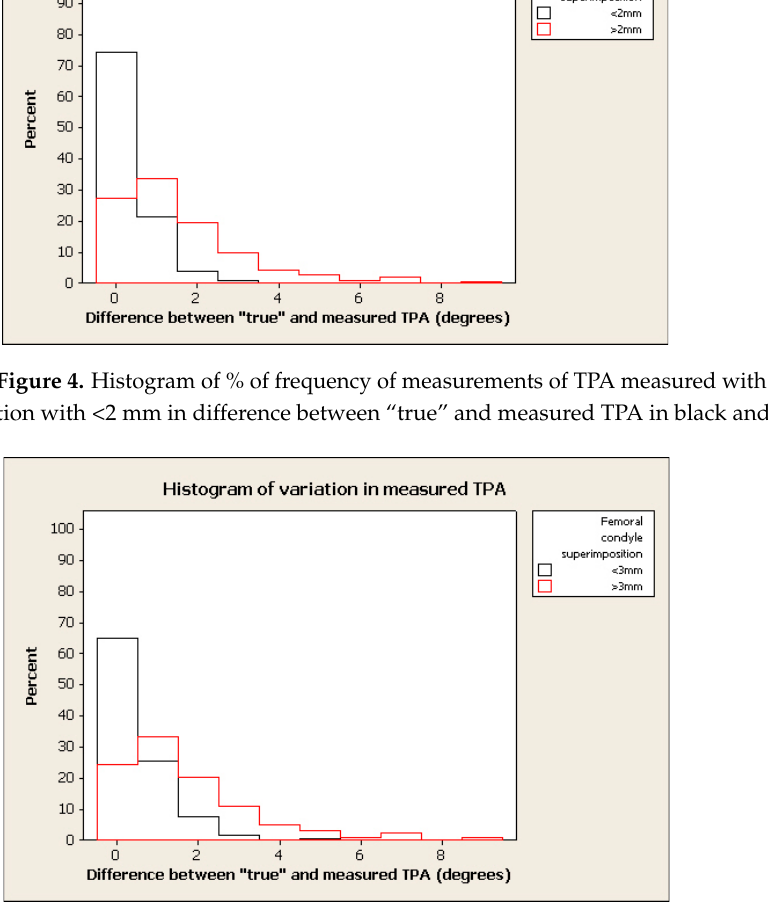
Figure 5. Histogram of % of frequency of measurements of TPA measured with femoral superimposition with <3 mm in difference between “true” and measured TPA in black and >3 mm in red.